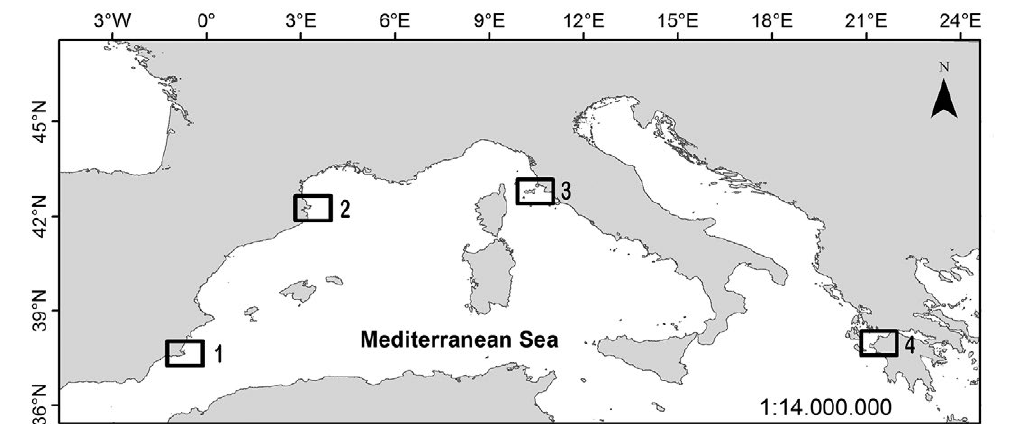
Fig. 1. – Map of the study area in the NW Mediterranean: 1, Murcia coast; 2, Catalan coast; 3, Tyrrhenian coast; 4, eastern Ionian coast.